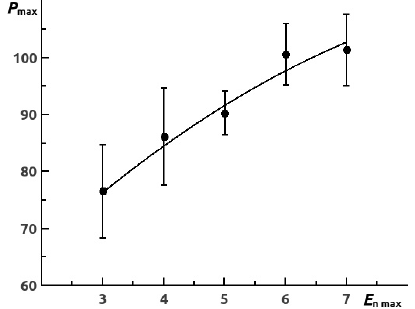
Fig. 10. The position of the maximum P max in the pulse height spectrum versus the maximum neutron energy E n max